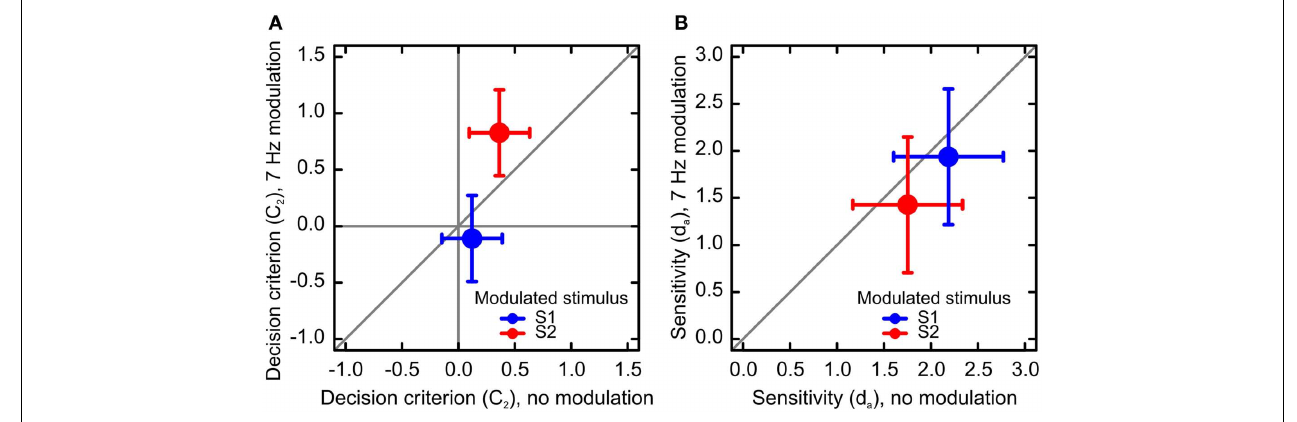
FIGURE 3 | Results of Experiment 2: bias and sensitivity. (A) Results of the analysis of decision criterion. Negative values of the criterion indicate a bias toward S1, and positive values indicate a bias toward S2.When S1 was modulated, observers were more likely to report that S1 was the longest stimulus, and vice versa for S2. Criterion was also affected by stimulus